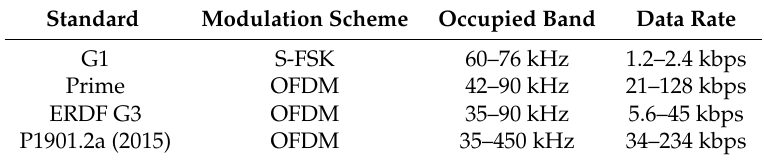
Table 4. Overview of low bitrate Power Line Communication (PLC)